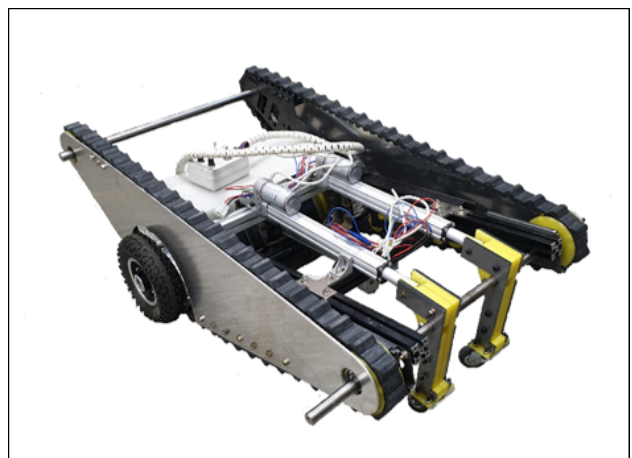
Figure 10. Manufactured wheelchair.